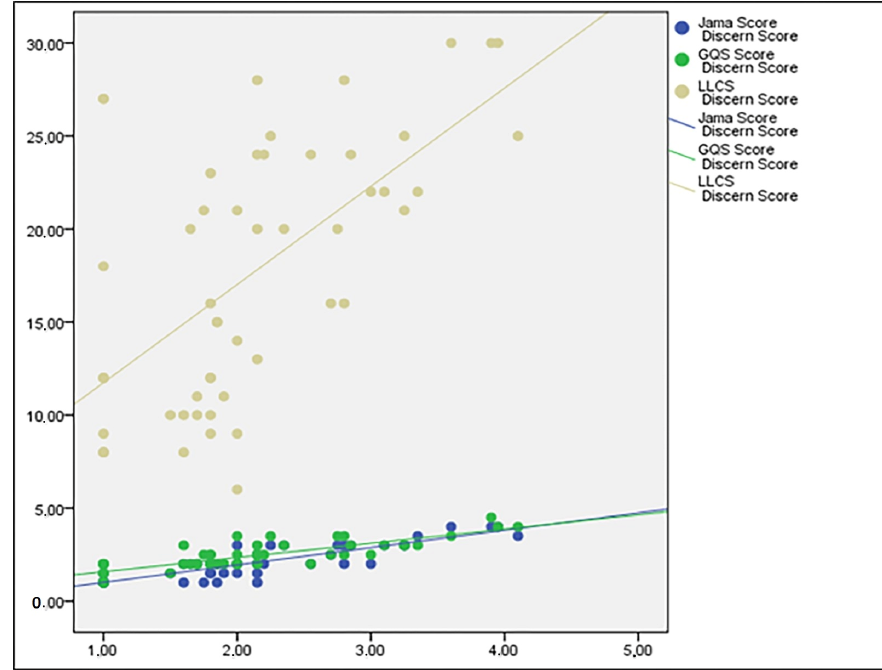
Figure 3. Relationship of DISCERN score to other scores.